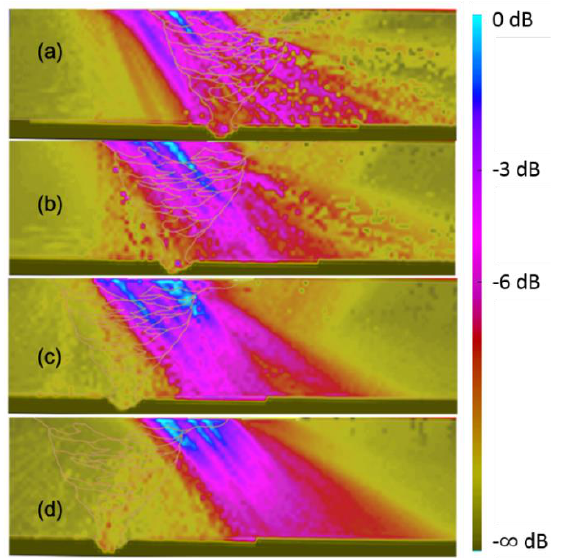
Figure 9. Longitudinal wave inspection. Scanning angle of 48 ◦ with 16 elements. Indexes: ( a ) 8 mm, ( b ) 22 mm, ( c ) 35 mm and ( d ) 49 mm.